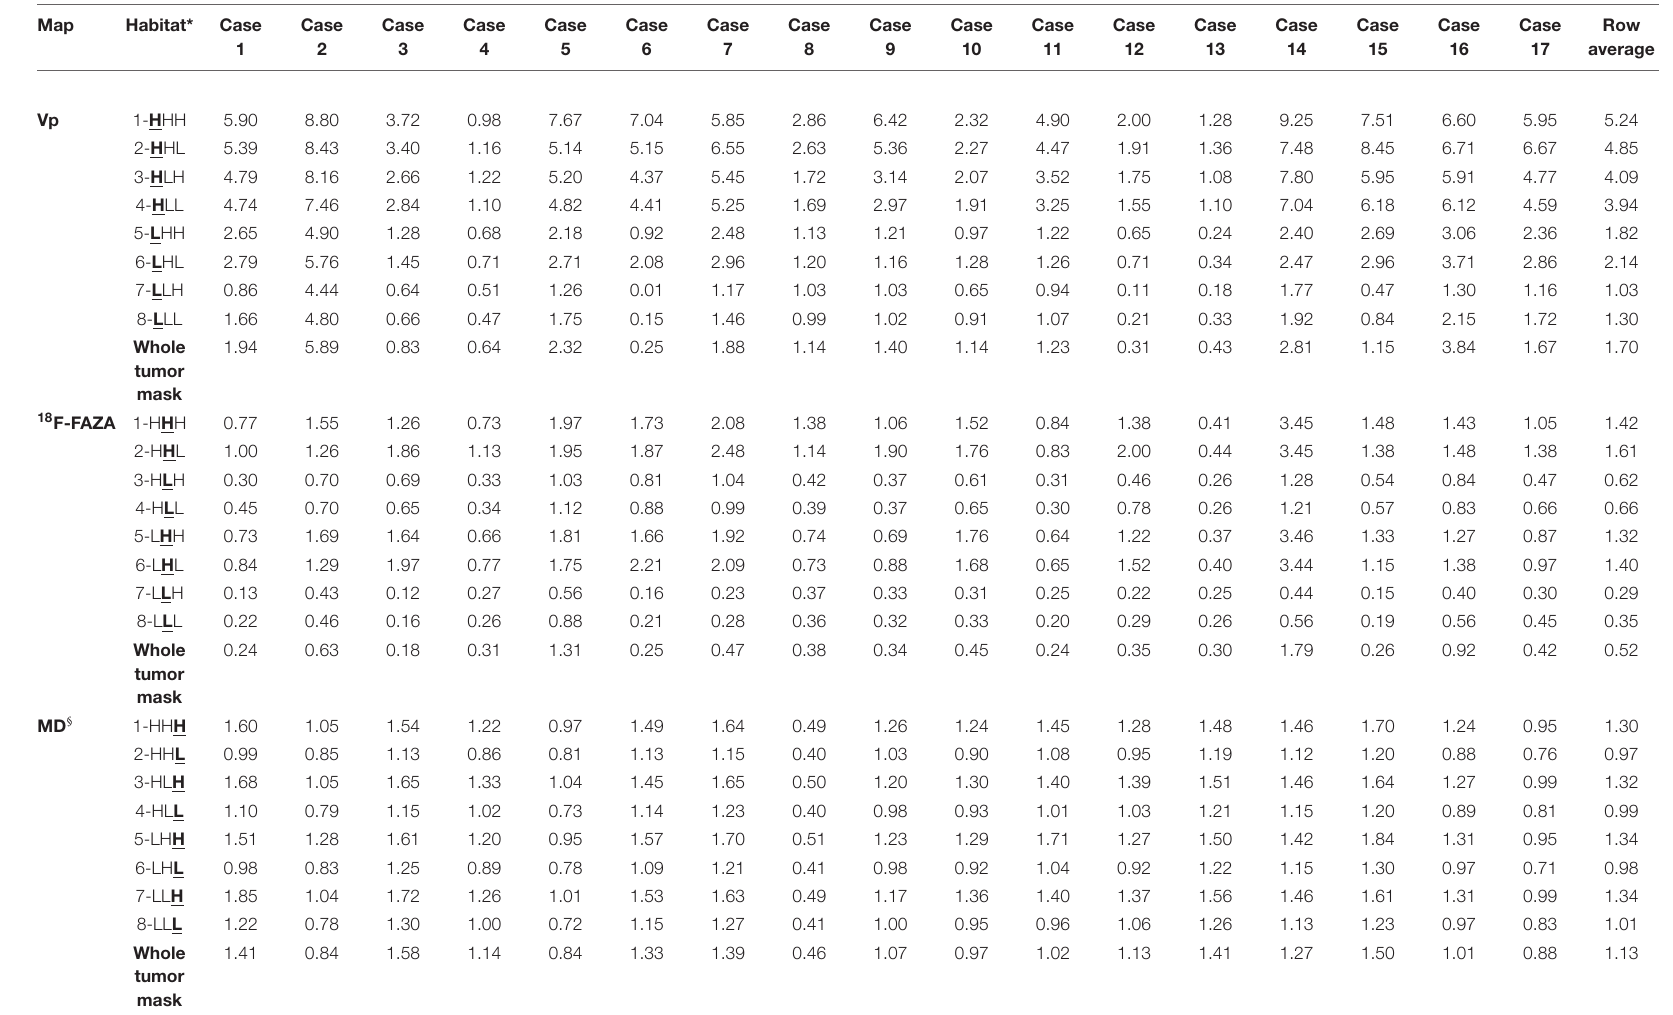
TABLE 3 | Plasma volume (Vp), 18 F-labeled fluoroazomycinarabinoside ( 18 F-FAZA), and mean diffusivity (MD) voxel median values among different habitats. Map Habitat*